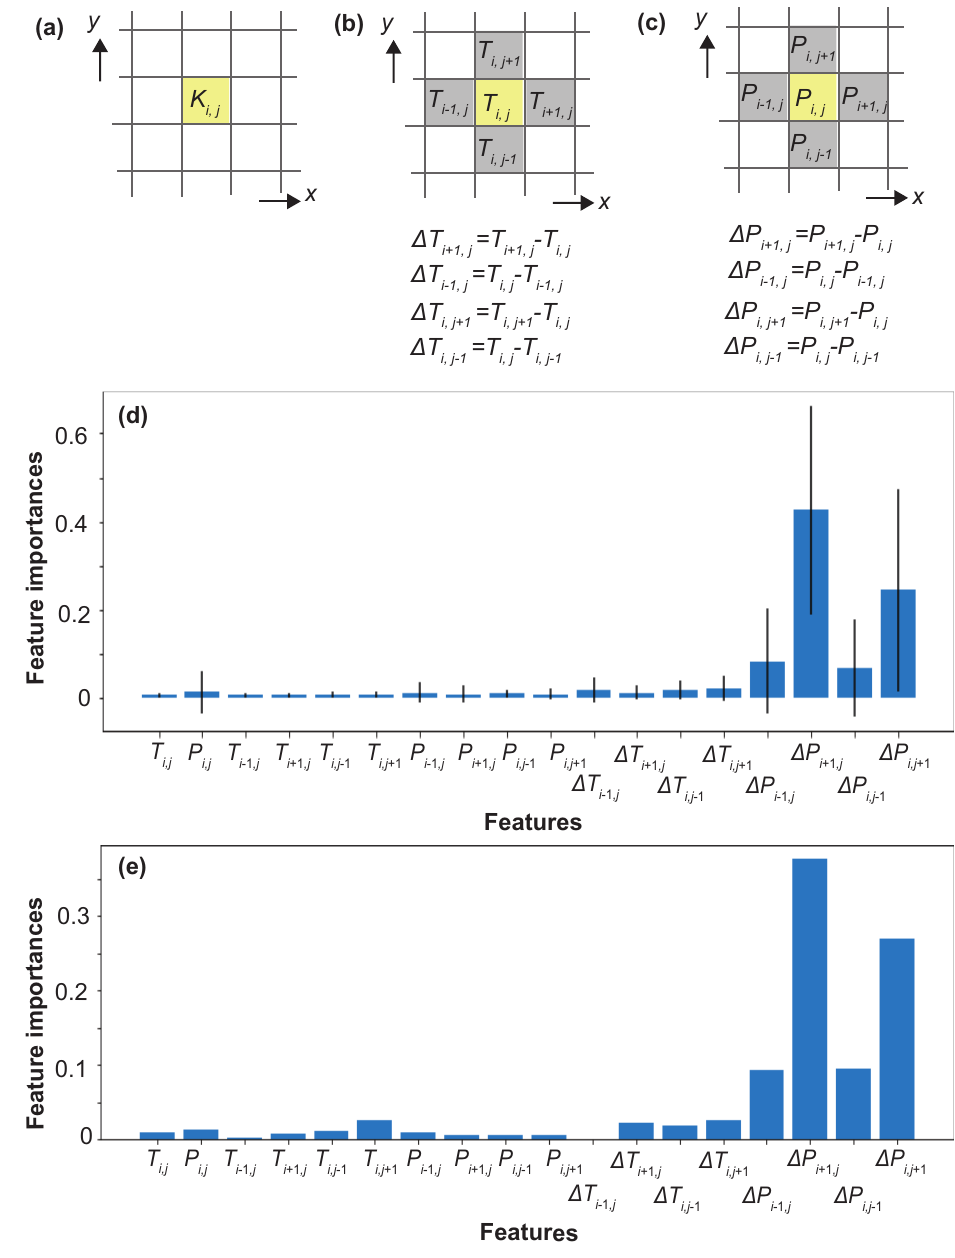
Figure 2. ( a – c ) Setting of feature variables: ( a ) permeability K i , j , ( b ) temperature T i , j , and ( c ) pressure P i , j for grid x = i and y = j . ( d , e ) Results of relative importance of feature variables based on training data with random forest for ( d ) grid-dependent models and ( e ) grid-independent